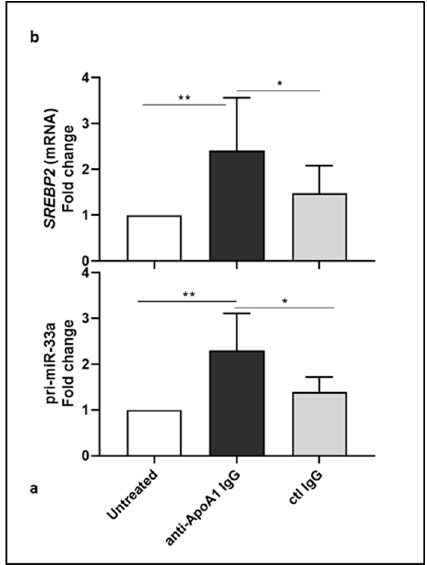
Figure 2. Primary miR-33a and SREBP2 mRNA are upregulated by anti-ApoA-1 IgG. Cells were treated with anti-ApoA-1 IgG or control antibodies for 24 h and RT-PCR was performed to determine pri-miR-33a and SREBP2 mRNA levels ( a , b ). Data are expressed as fold change expression of the mean ± SD of pri-miR-33a or SREBP2 mRNA calculated by ∆∆ CT method of five independent experiments ( n = 5) and values were normalized to untreated condition. p -values were calculated using the Student’s t -test. ( a ), * p = 0.032, ** p = 0.0031; ( b ), * p = 0.043, ** p = 0.007.